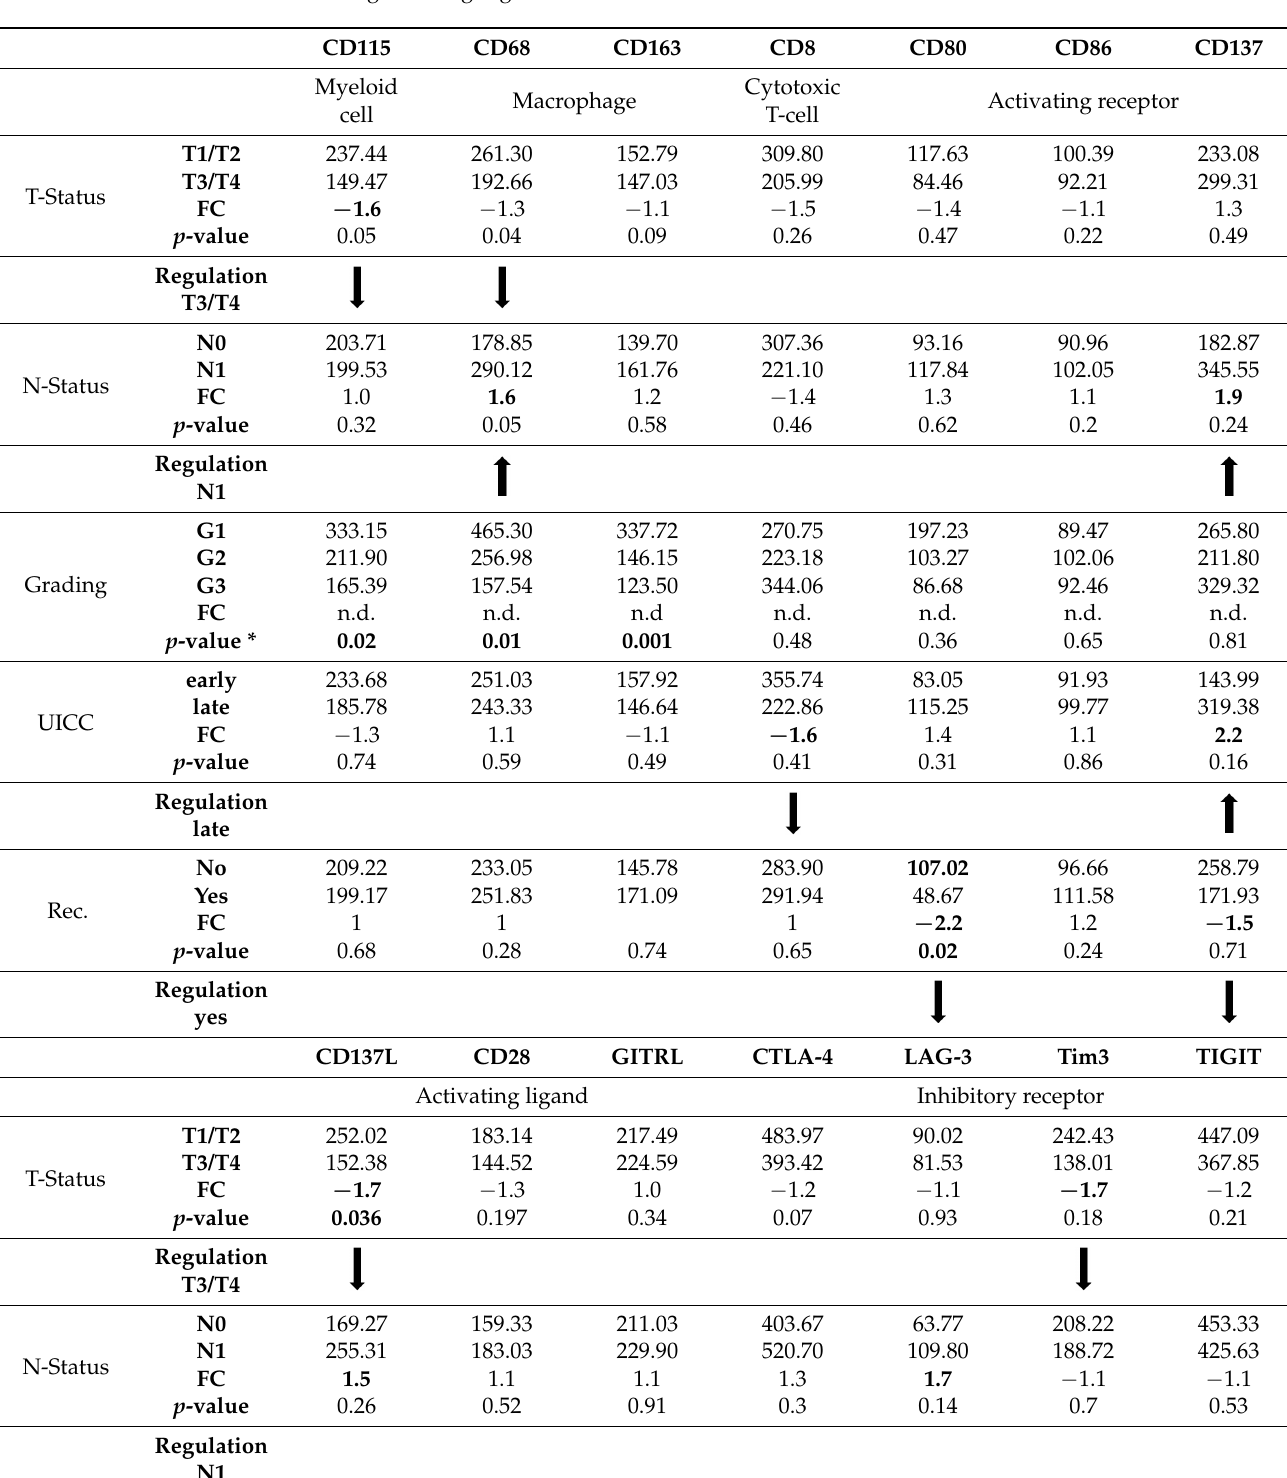
Table 4. Average of counts in specific groups, changes in expression levels (FC) and statistical relevance of differential expression in OSCC tissues depending on tumor size, lymph node status (N), clinical stage (UICC), grading (G) and recurrence (Rec.). Number of OSCC = 98. Statistically relevant changes are highlighted in bold. All significances are calculated by means of the MWU test with the exception of grading (* Kruskal–Wallis Test). FC significance level was 1.5 times. Statistically relevant changes are highlighted in bold.